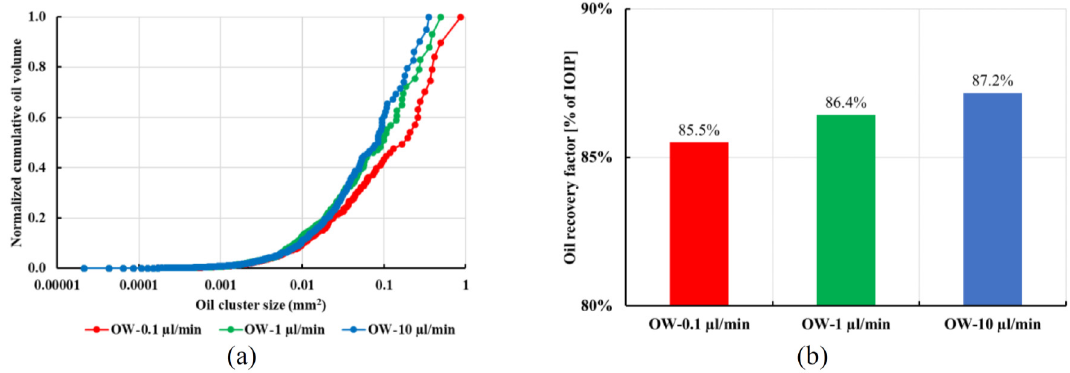
Figure 10. Response in ( a ) cluster size distribution and ( b ) oil recovery due to increasing the flow rate